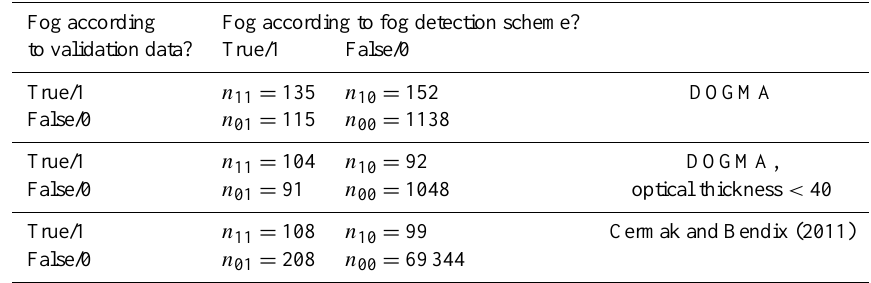
Table 5. Confusion matrices for the validation of the DOGMA ground fog product.